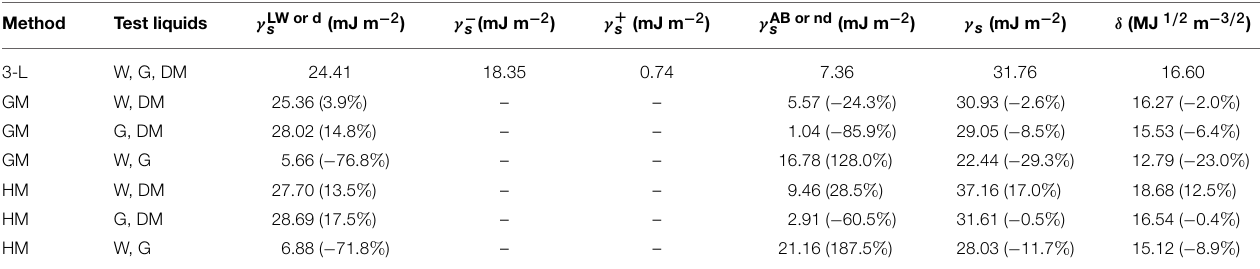
TABLE 6 | Surface free energy ( γ s ) and its components ( γ LW or d